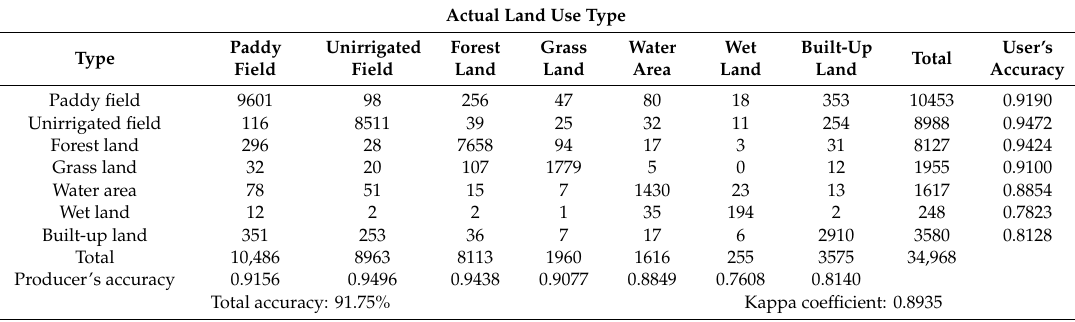
Table 12. Accuracy assessment of the land use simulation results in 2018.